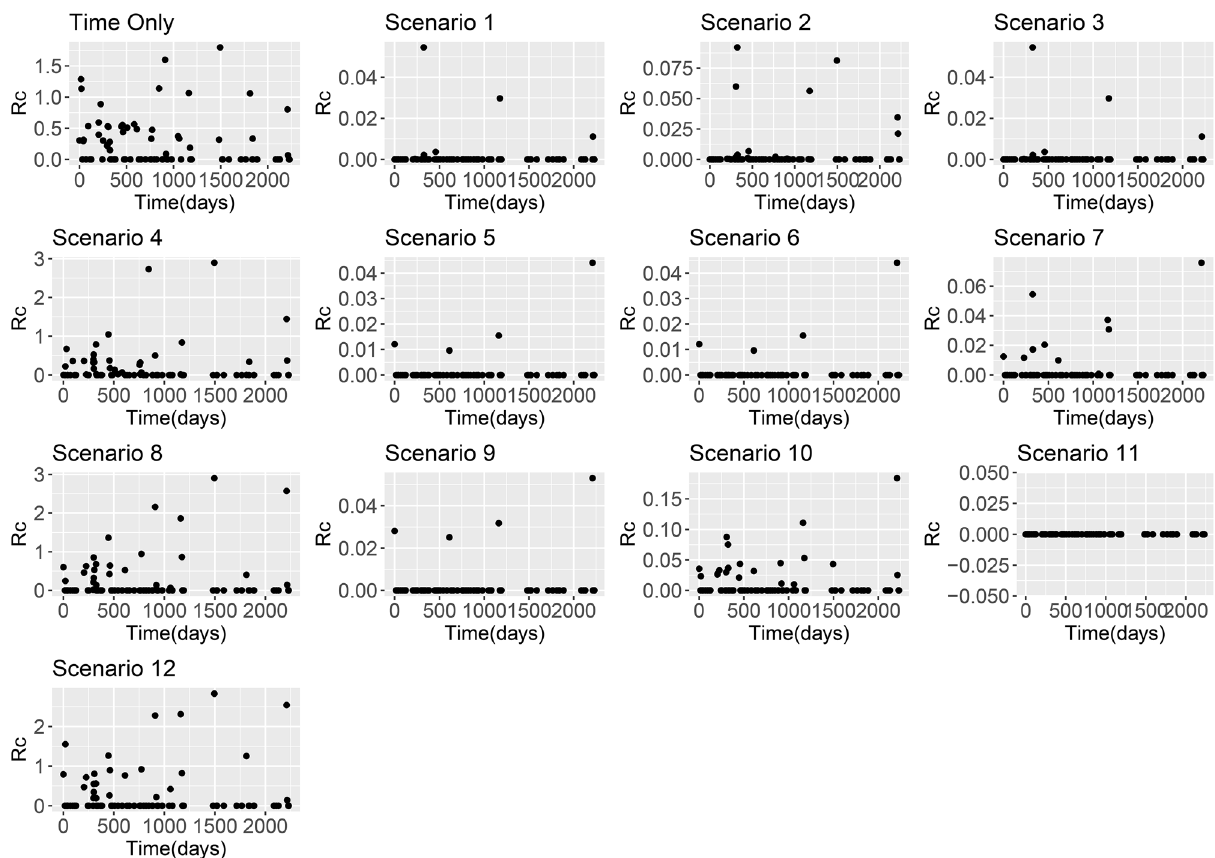
Figure 1. R c estimates from El Salvador line list based on using the time-only scenario and Scenarios 1–12 with an exponential